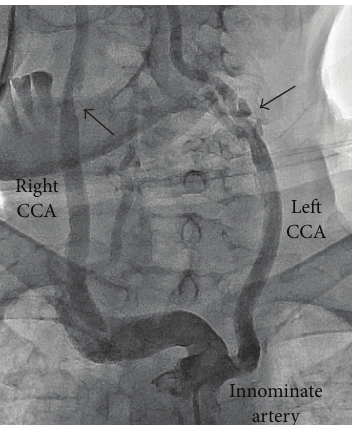
Figure 1: Aortic arch angiogram revealed critical stenosis in the proximal right internal carotid artery (black arrow), variant origin of the left common carotid artery from the innominate artery, and also critical stenosis in the proximal left internal carotid artery (black arrow) (CCA: common carotid artery).